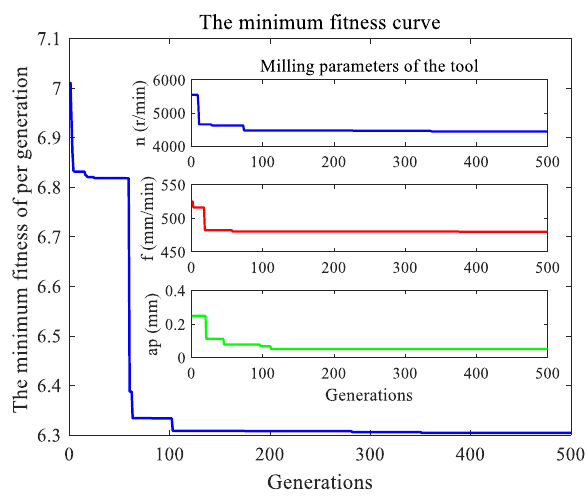
Figure 17. Genetic algorithm (GA) optimization process. Table 5. GA optimization results.